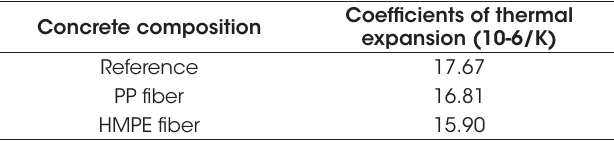
Coefficients of thermal expansion